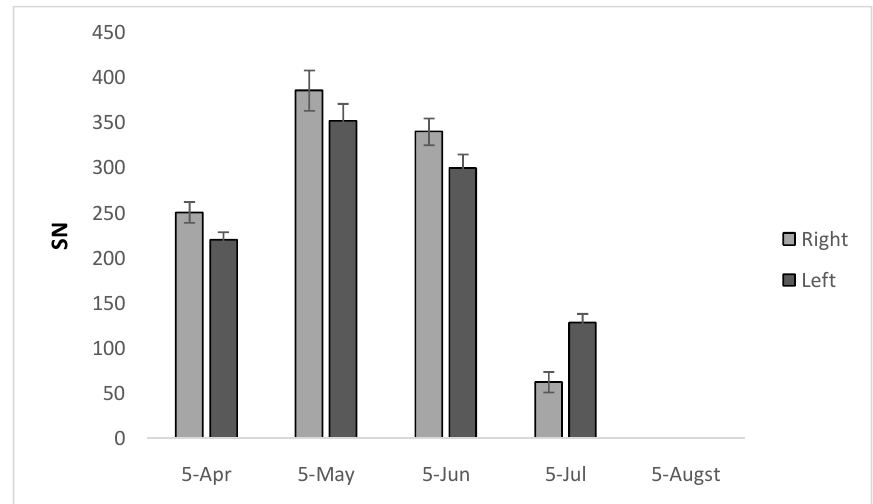
F IGURE 5. Mean of sperm number (SN) of Teratoscincus bedriagai from April to August